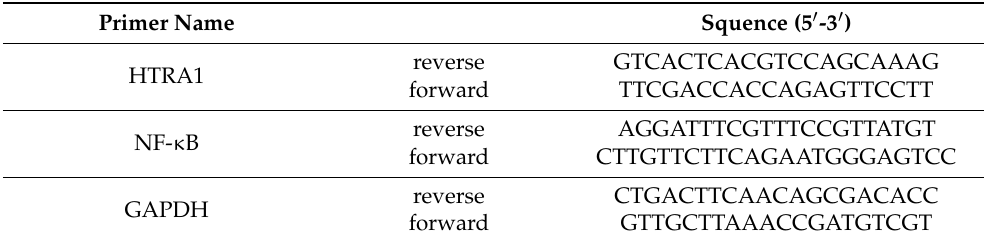
Table 1. Primers for Quantitative RT-PCR